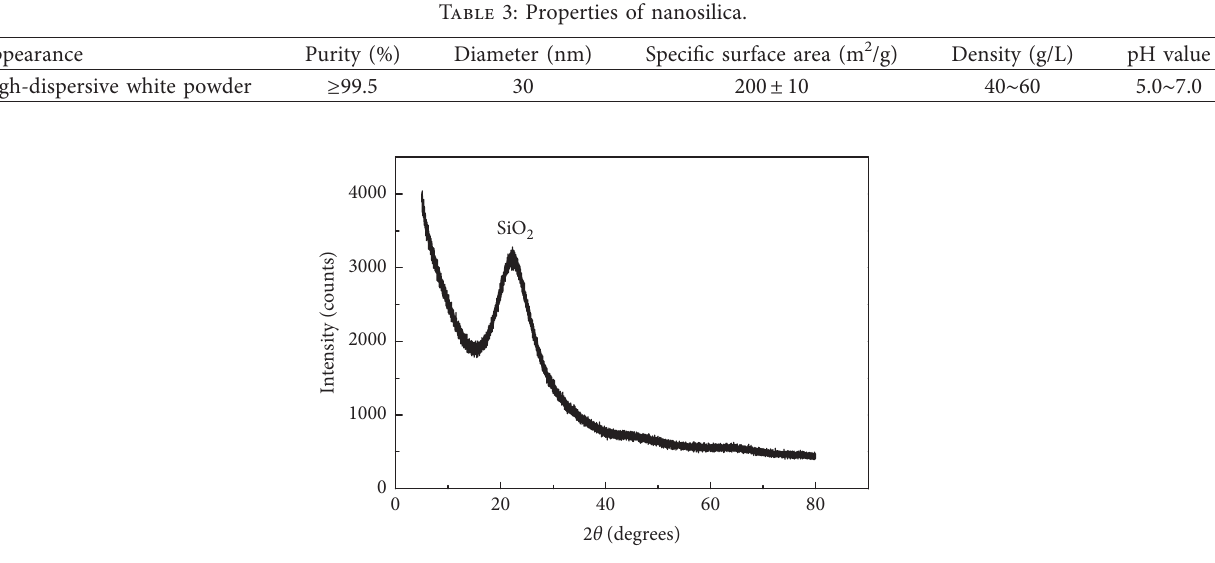
Figure 2: XRD pattern of